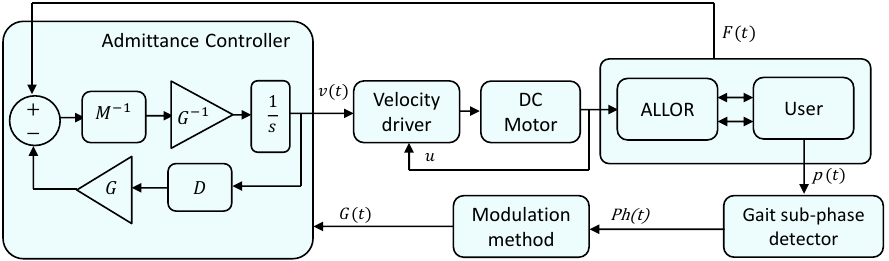
Figure 7. Admittance controller implemented at the active knee